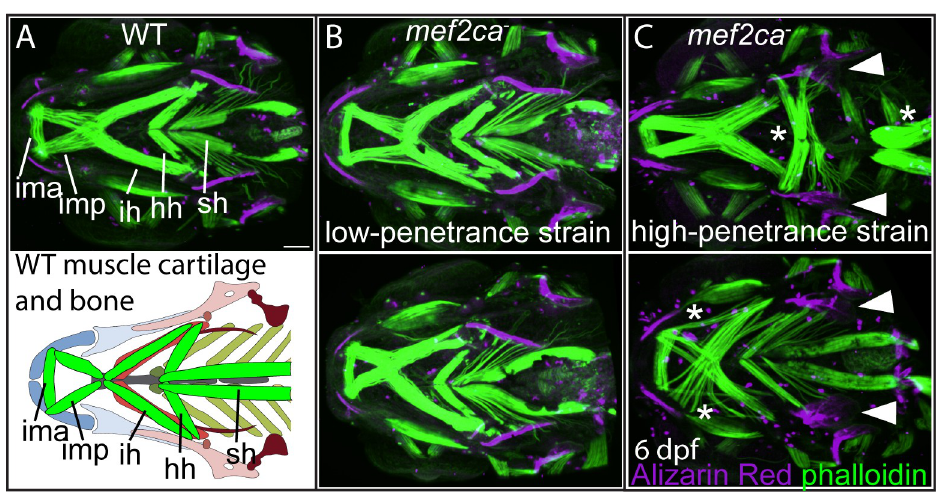
Fig 3. Selective breeding just for ectopic bone penetrance modifies penetrance of craniofacial muscle phenotypes. 6 dpf larvae were stained with Alizarin Red (magenta) and fluorescently labelled phalloidin (green) to mark bones and muscles, respectively. (A) The following craniofacial muscles are indicated in the micrograph and graphic: intermandibularis ant. (ima), intermandibularis post. (imp), interhyal (ih), hyohyal (hh), sternohyoideus (sh). Scale bar: 50 μ m. (B) In the low-penetrance strain, mef2ca mutant muscles and bones resemble wild types. (C) In the high- penetrance strain, mef2ca mutants manifest muscle phenotypes (asterisks) in conjunction with ectopic bone phenotypes (arrowheads).